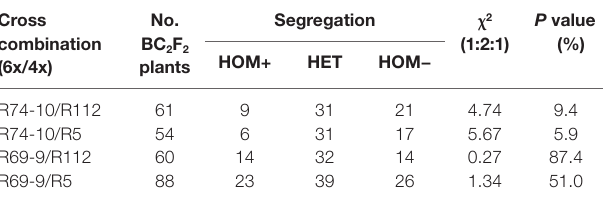
TABLE 4 | Segregation ratios of novel 7A recombinant chromosomes in tetraploid